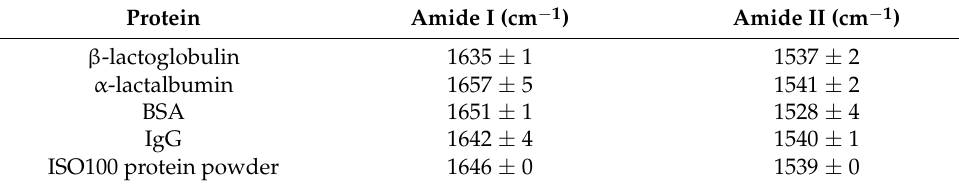
Table 4. IR data comparing whey protein standards to ISO100 protein